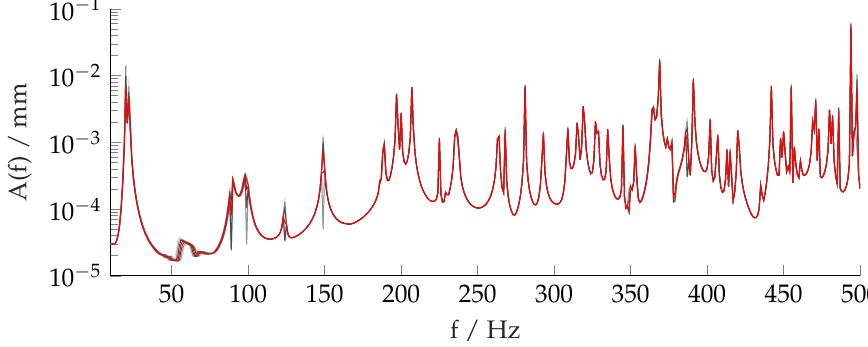
Figure 8. Fuzzy frequency response in the range from 10 Hz to 500 Hz.